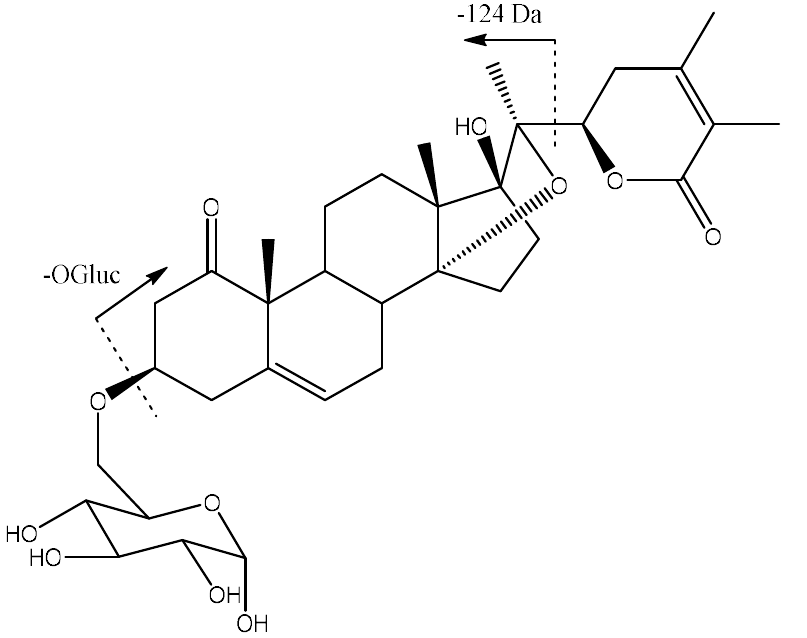
Figure 8. Structure and fragmentation of Physagulin O. Peak 28 (Rt = 23.59 min) with [M-H] − at m / z 631.3137 (C 34 H 47 O 11 ) was tentatively as- signed to the previously described 14,20-Epoxy-(22R)-3 β -(O- β -glucopyranosyl)-17 β -hydroxy- 1-oxowitha-5,24-dienolide [39], with fragments at m / z 451 due the loss of glucose [M-H- OGluc] − and m / z 433 [M-H-OGluc-H 2 O] − and m / z 309 [M-H-Gluc-H 2 O-124] − due to the loss of lactone (124 Da), as shown in Figure 9.